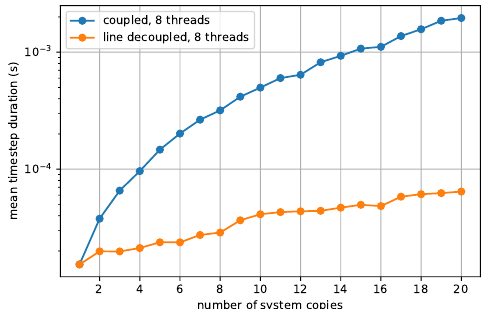
Figure 16. Parallelization results for eight threads comparing different decoupling